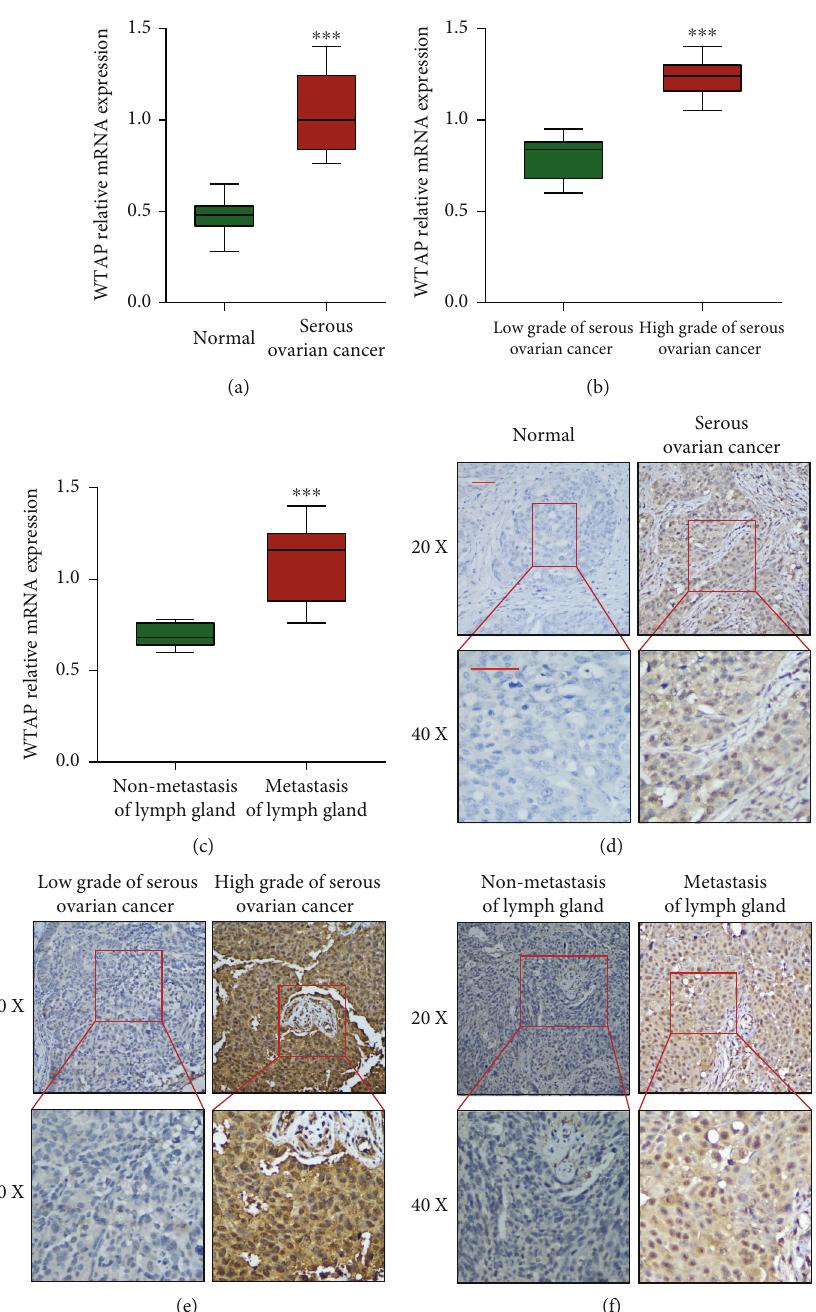
Figure 2: The expression of WTAP is signi fi cantly upregulated in ovarian cancer tissue and closely correlated with clinicopathological parameter. (a) The mRNA expression of WTAP was upregulated in serous OC tissues compared with normal tissues. (b and c) WTAP expression was relatively higher in high grade OC tissues and those with metastasis of the lymph gland. ∗∗∗ P < 0 : 001 . (d) Comparisons of WTAP expression in tissues revealed by IHC analysis in normal and serous OC tissues. (e) Comparisons of WTAP expression in tissues revealed by IHC analysis, low grade and high grade of serous OC tissues. (f) Comparisons of WTAP expression in tissues revealed by IHC analysis, nonmetastasis and metastasis of lymph gland tissues. The positive staining of WTAP was presented in brown color (distributed in both nucleus and cytoplasm), and the cell nuclei were counterstained with hematoxylin. Original magni fi cation, 20x (left panels) and 40x (right panels). Scale bars = 10 μ m